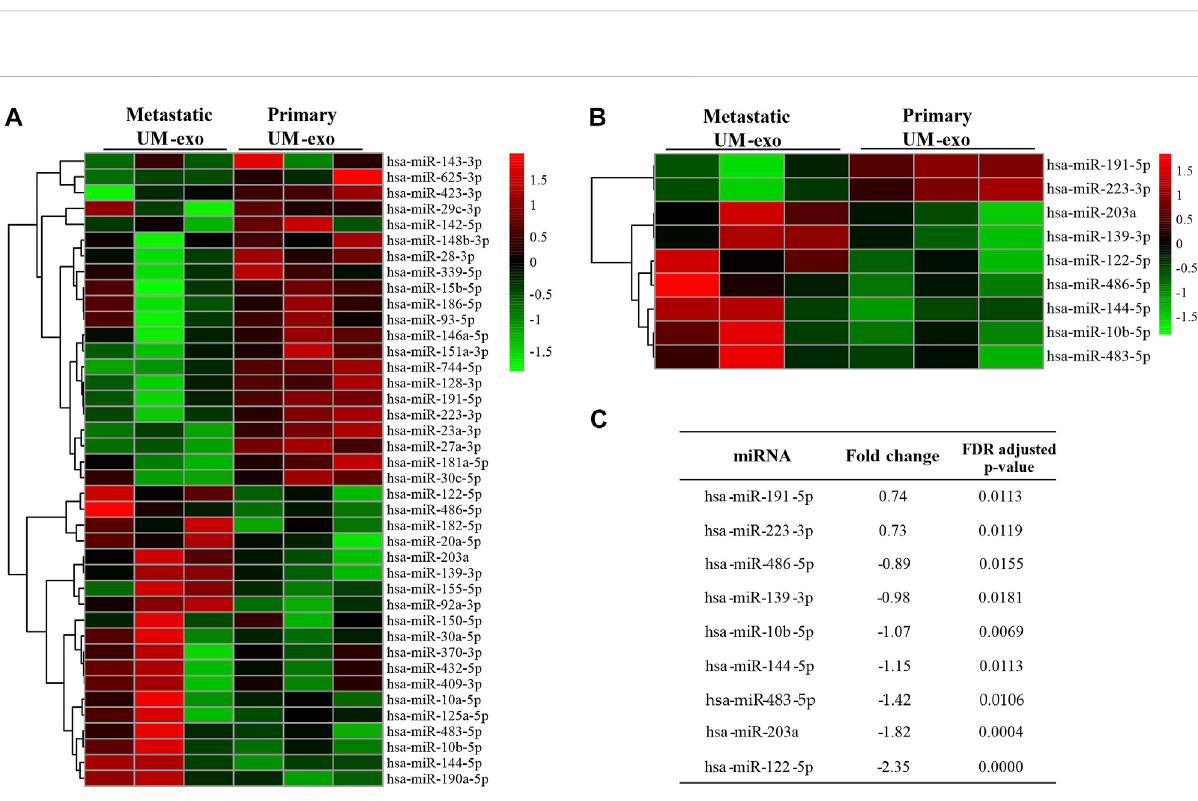
MiRNAsdifferentiallyexpressed(DE)inexosomesderivedfrom3patientseachwithprimary(Primary UM-exo)ormetastaticdisease(Metastatic UM-exo). (A) Heatmap showing top 40 DE miRNAs (20 up-, 20 down-regulated) in EVs from metastatic UM patients compared to EVs from primary UM patients; (B) Heatmap with statistically signi fi cant DE miRNAs in EVs from metastatic versus primary UM patients; (C) Table showing log2